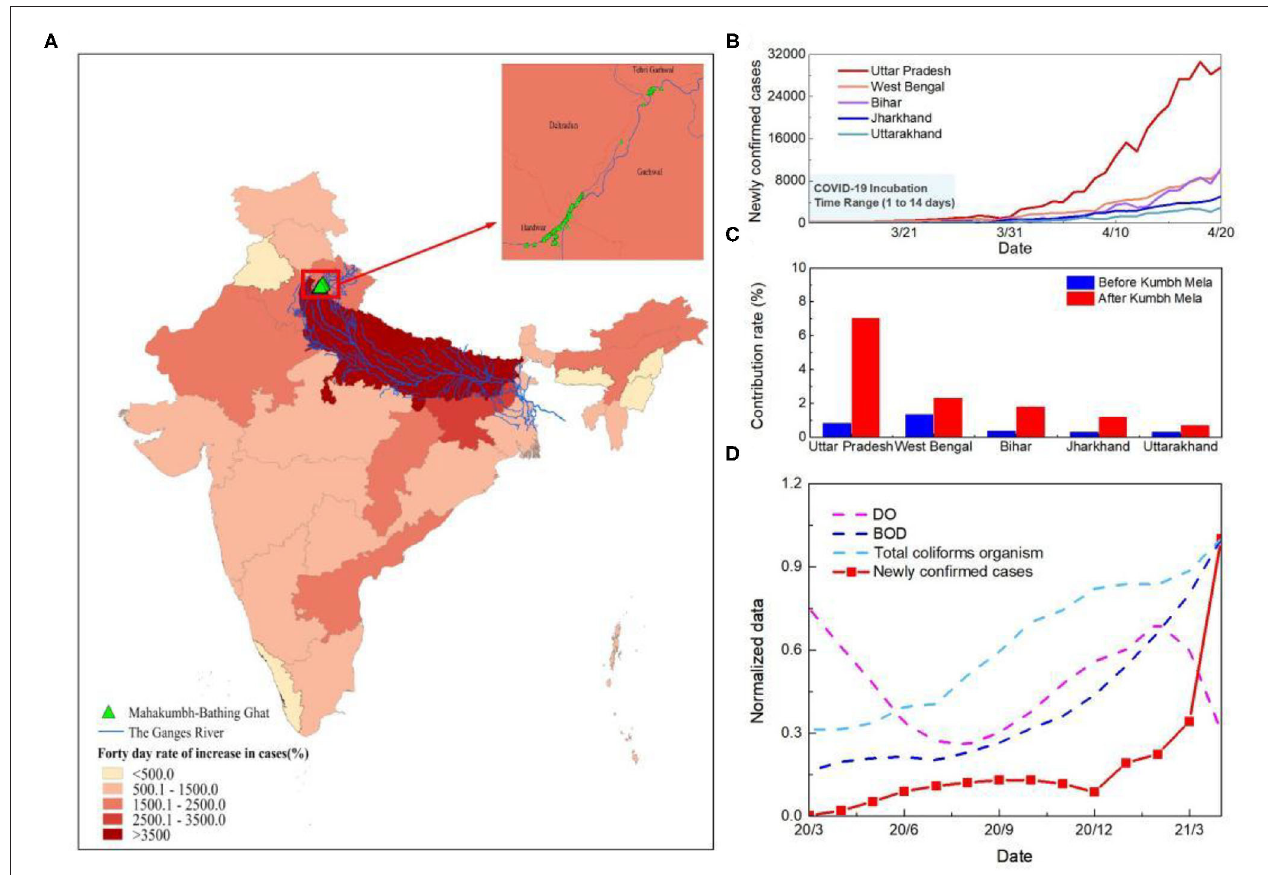
FIGURE 3 | Analysis of the causes of the second outbreak in India. (A) Spatial distribution of the growth rate of the number of cases at 40 days since Kumbh Mela in India. (B) Time series curve of newly confirmed cases in five states along the Ganges River basin in India. The light blue shaded area represents the incubation period of SARS-CoV-2. (C) Change in the number of new cases as a percentage of India’s total in the five states in the Ganges basin. The columns represents the proportion of newly confirmed cases at 40 days before and after Kumbh Mela. Blue is pre-Kumbh Mela and red is post-Kumbh Mela. (D) Time series of water quality and new confirmed cases in Uttar Pradesh. The red line represents the number of new confirmed cases and the other three dotted lines represent DO, BOD, and Total coliforms organism. To facilitate the comparative analysis, the data were